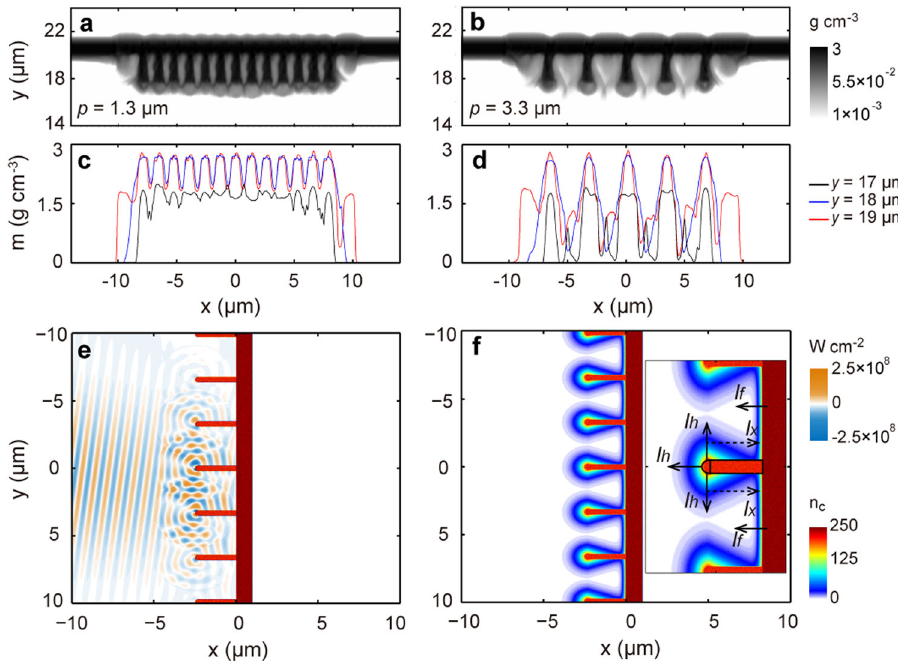
Fig. 3 The characteristics of pre-plasma for microwire array (MWA) target. Expanded pre-plasma of MWA targets after loading the pre-pulse in FLASH simulations for p = 1.3 μ m ( a ) and p = 3.3 μ m ( b ). Mass density distribution along y = 17 μ m (black), 18 μ m (blue) and 19 μ m (red) for p = 1.3 μ m ( c ) and p = 3.3 μ m ( d ) related to ( a ), ( b ), respectively. The diffracted pre-pulse fi eld E x within the MWA structure ( e ). The density distribution of pre-expanding MWA target based on the FLASH results ( f ), which is inputted into particle-in-cell simulations. The inset shows the pre-plasma scale lengths, where l h and l x are for the pillars, and l f for the substrate fl